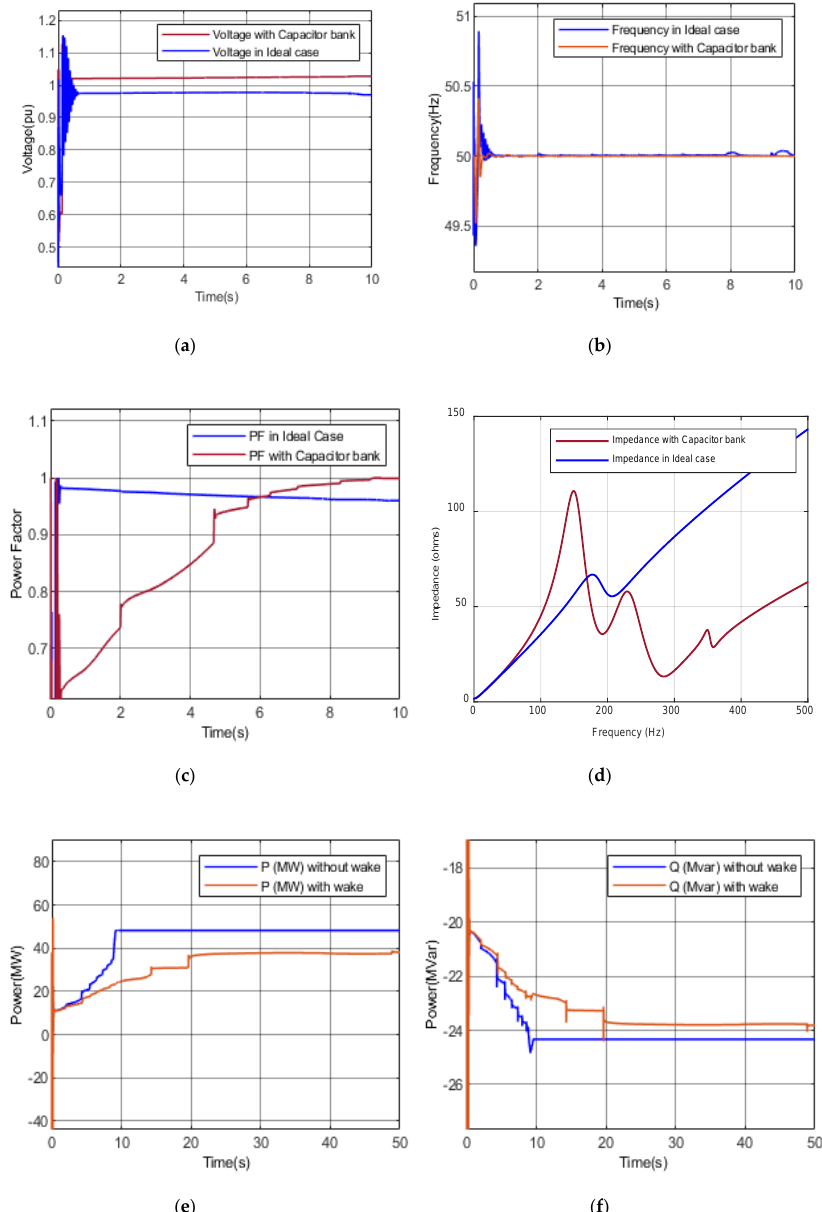
Figure 9. Case-2, Scenario 6: ( a ) Voltage (V) at PCC; ( b ) frequency (F) at PCC; ( c ) PF at PCC; ( d ) impedance (Z) vs. F; ( e ) P-trend; and ( f ) Q-trend.